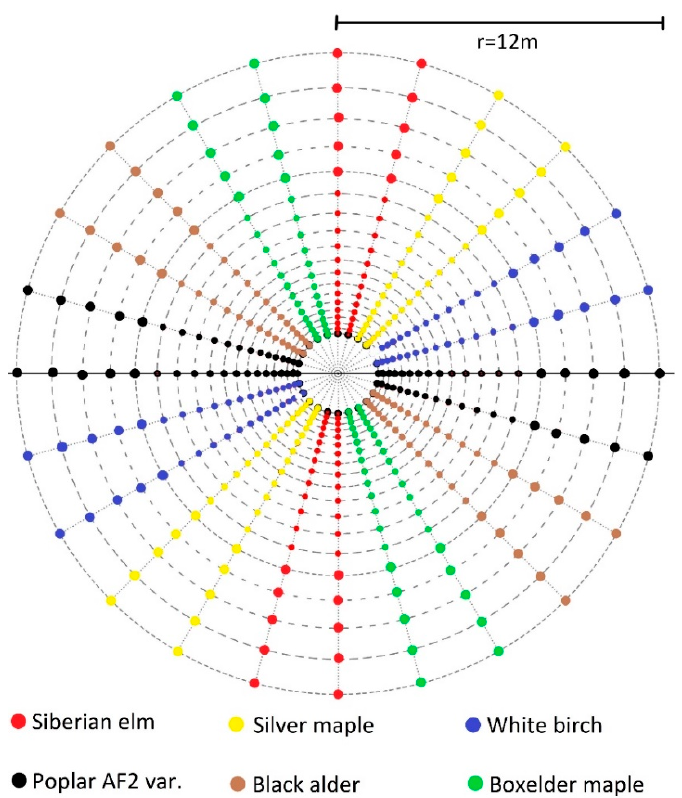
Figure 1. Distribution of species in the experiment design according to Nelder (1962) design (dots of different color represents trees of different species). Table 1. Planting distances and tree densities.